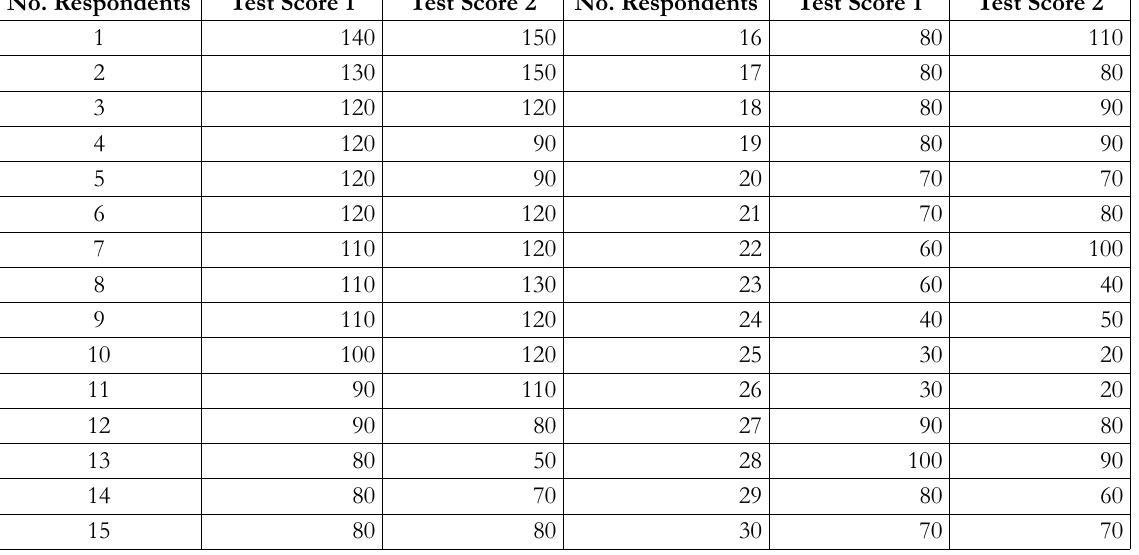
Table 1. Comparison of Test Scores 1 and 2